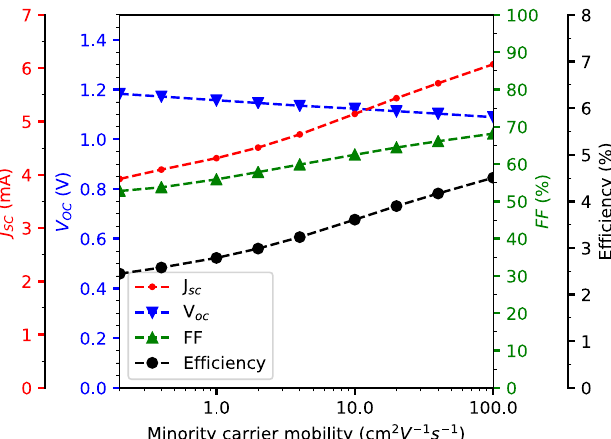
Fig. 7. Evolution of the solar cell performances with the carrier mobility using typical physical parameters obtained by the spray pyrolysis